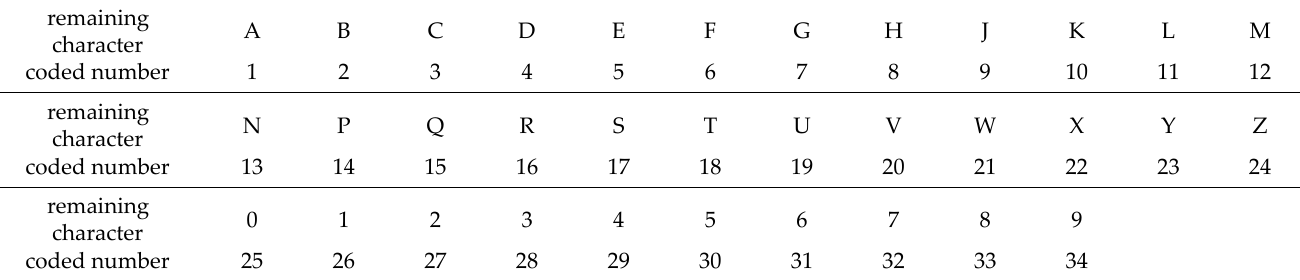
Table 3. Encoding of the third‑to‑seventh characters in the license